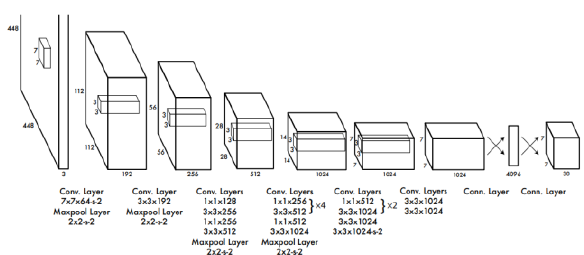
Figure 2 . The general structure of YOLO architecture (Redmon et al.,